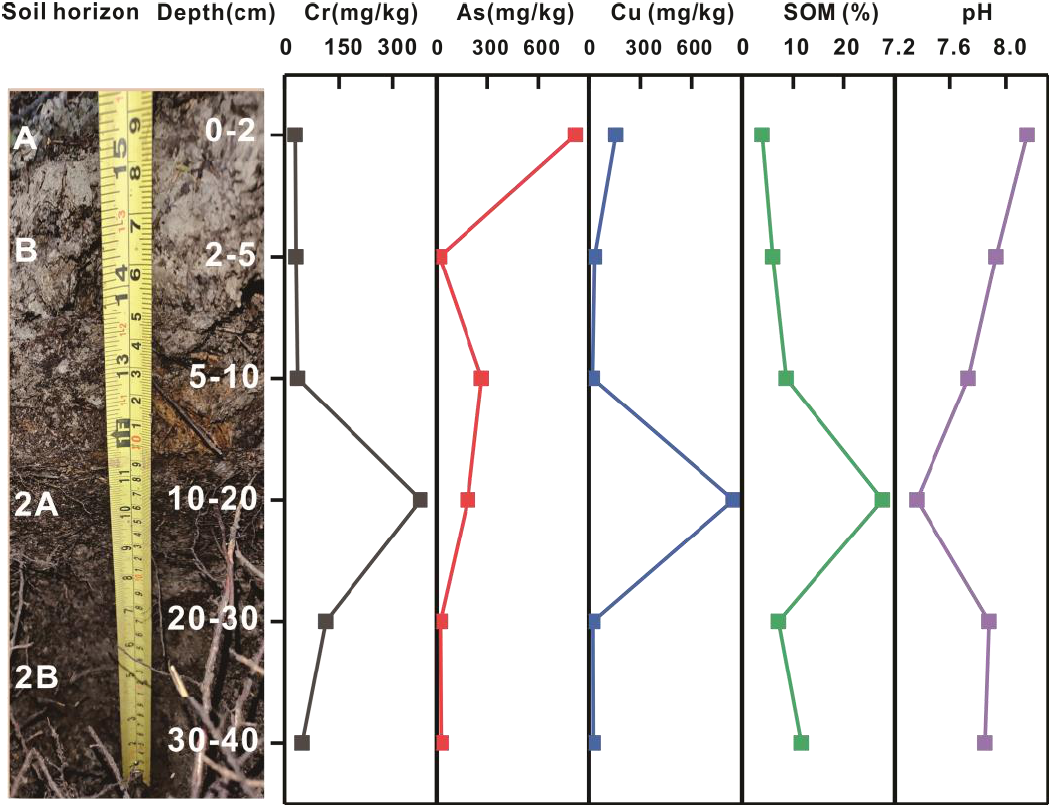
Figure 10. Distribution of Cr, As, Cu, SOM, and pH in the CCA plus CA-2 profile. As concentrations in surface soils (0–10 cm) under the CCA- and CCA plus CA-treated trestles were ~19.3 and 4.6 times higher than those in background soils, respectively. As- contaminated soils are ecotoxic and carcinogenic [113]. The toxic effects of As are dependent on several factors, of which the chemical speciation (inorganic or organic) and oxidation state are most important. Inorganic As is more toxic than organic As, and As(III) in inorganic is more toxic (2–10 times) than As(V) [114]. Furthermore, As(III) might occur in surface and subsurface environments up to 40% of the total As [115], and leached As(III) from CCA- treated wood was present in soils [69]. In our study, As was more vertically mobile than Cr and Cu, with enrichment depths up to 10 cm, and exchangeable fractions of 0.22–17.59% and 2.25–5.63% were observed in the profiles under the CCA- and CCA plus CA-treated boardwalks, so it is presumed that As was mainly present as As(III). As phytotoxicity is also affected by aging, and the EC50 threshold for As phytotoxicity increased 1.76-fold for soils aged 5 years compared to those aged 0.25 years [97]. Furthermore, EC50 is highly dependent on soil properties [116]. Acidic soils have greater EC values than moderately alkaline soils [97]. In this study, the soils under the CCA and CCA plus CA treatments were mostly moderately alkaline, so the smaller the corresponding EC values were,